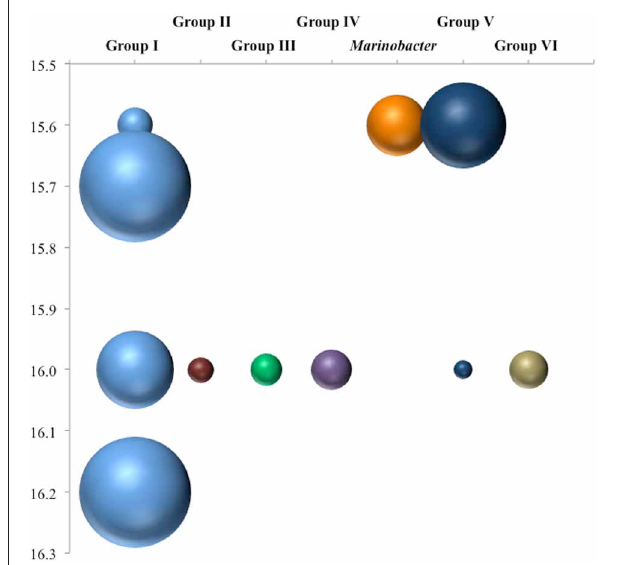
FIGURE 7 | Depth breakdown of groups noted in Figure 6. Areas of bubbles are proportional to percentage of clone library sequences for a given depth found in a given